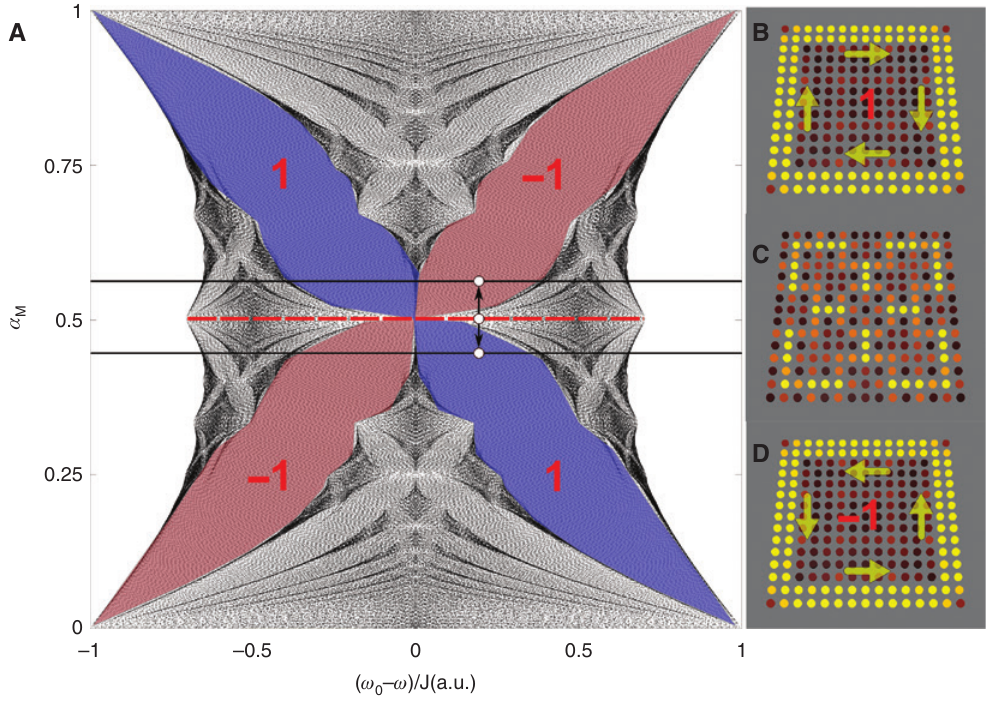
Figure 1: Tight-binding modeling. (A) The Hofstadter butterfly spectrum for a 15 × 15 resonator system. Eigenfunctions of the three different states: (B) (1) 0.45, α = trivial state; and (D) (3) 0.55, α = topologically protected state with negative Chern ; (C) (2) 0.5, protected state with unity Chern number C + 1 M M . The arrows show the direction of the propagation of probability currents in the corresponding edge states. number C −1